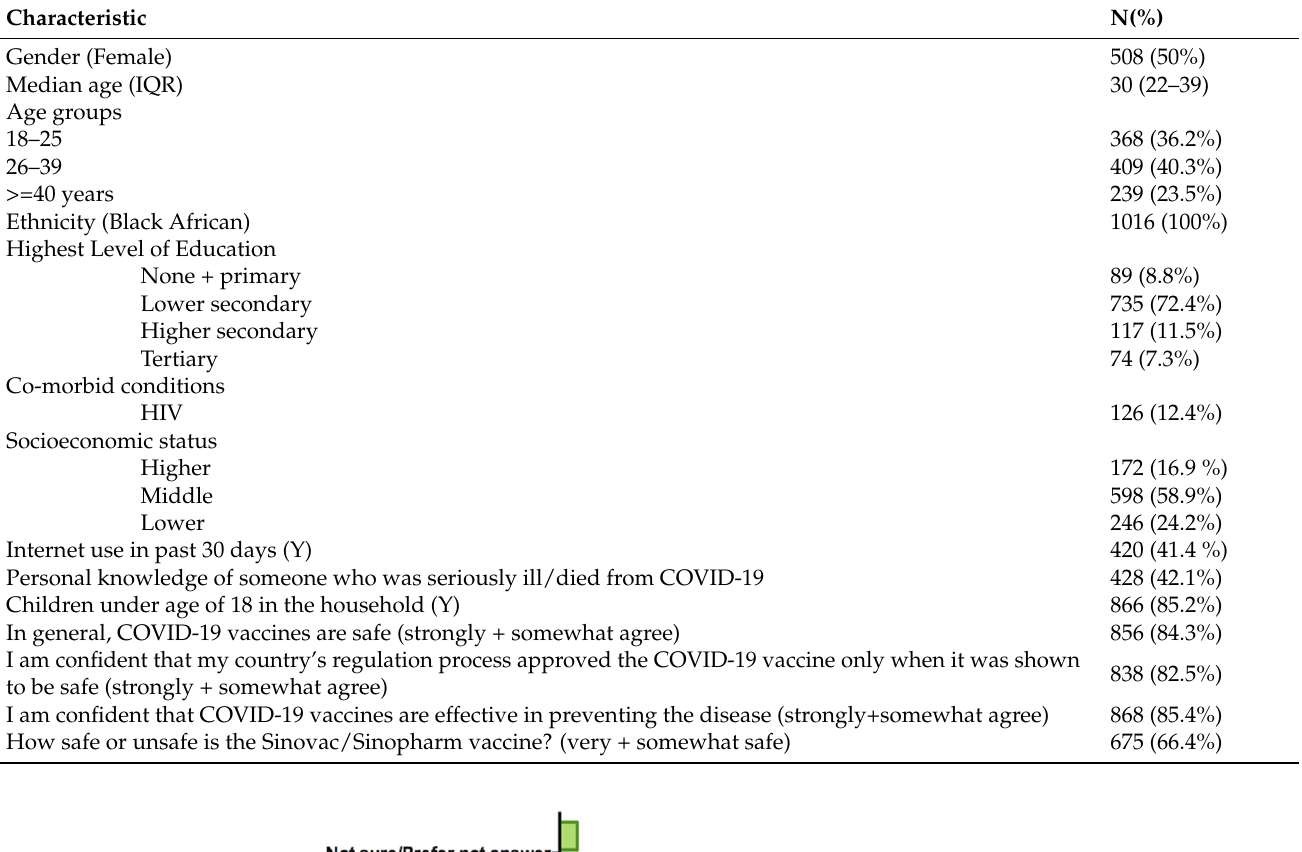
Table 2. Baseline cohort demographics and perceptions of vaccine safety, effectiveness, and trust in regulatory processes of study cohort ( n = 1016).